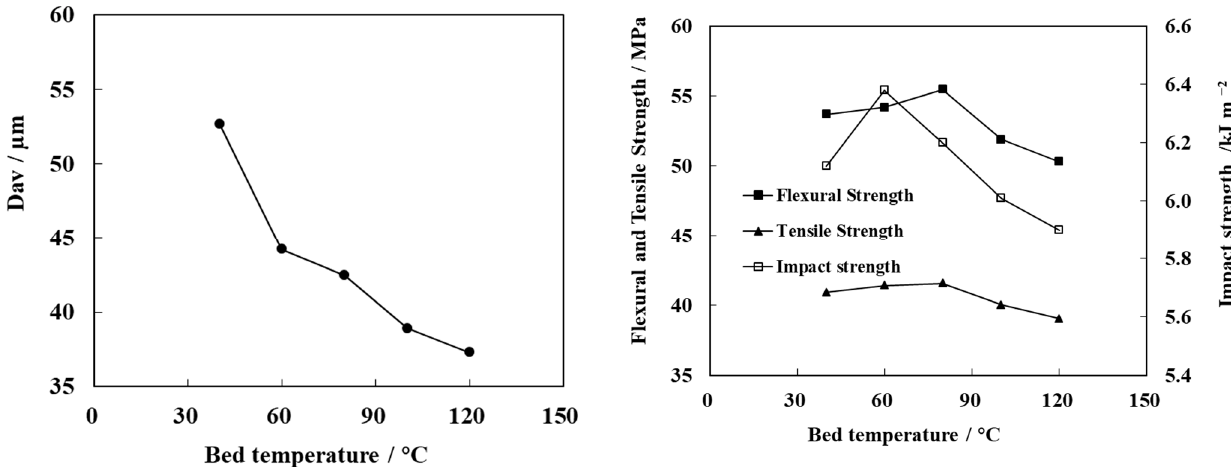
Figure 9. Effect of bed temperature on the average particle size of modified N-WPCBs and the mechanical properties of